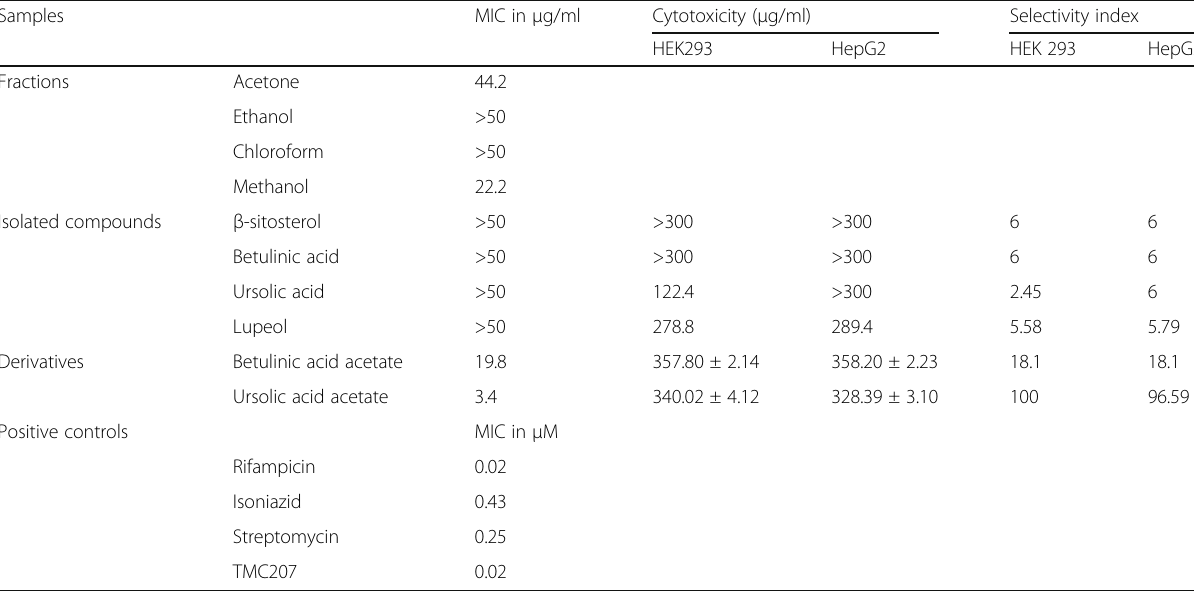
Table 1 Anti-mycobacterial activity of extracts, compounds and derivatives from C. dentata